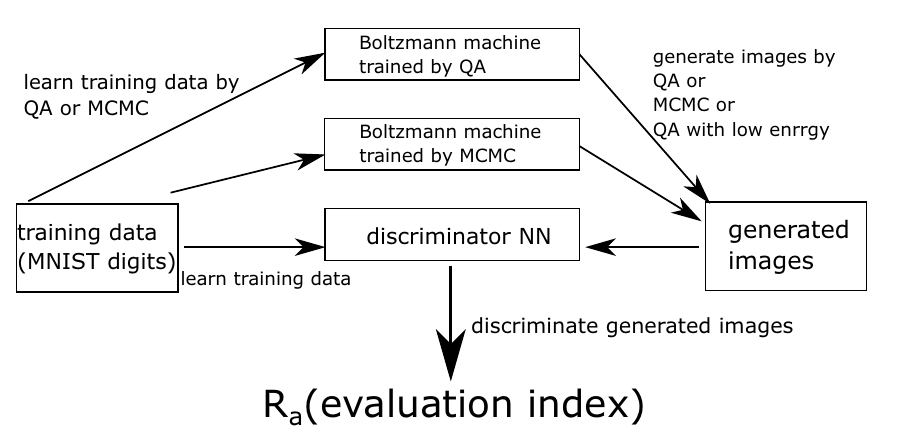
Figure 3. Summary of experiments performed in this